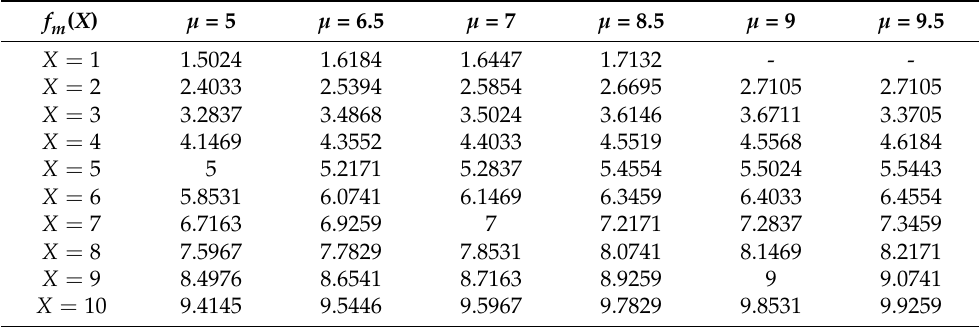
Table 3. Dependence of the function f m ( X ) value on the mean of f ( θ ) and the grade X in case